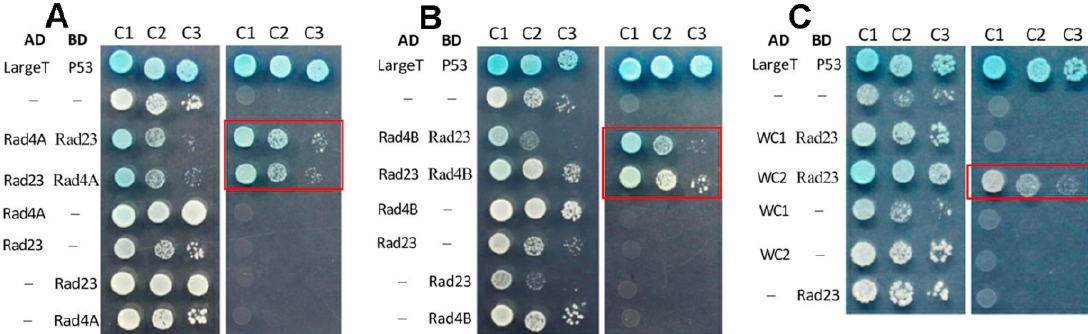
Figure 2. Y2H assays for an interaction of either Rad4A ( A ) or Rad4B ( B ) with Rad23 and of Rad23 with WC2 ( C ). Note that the target diploids (framed in red) and the positive control (AD-LargeT- BD-P53) grew well on the quadruple-dropout plate during a 3-day incubation at 30 °C after inoc- ulation with 5 × 10 4 (C1), 5 × 10 3 (C2) and 5 × 10 2 (C3)